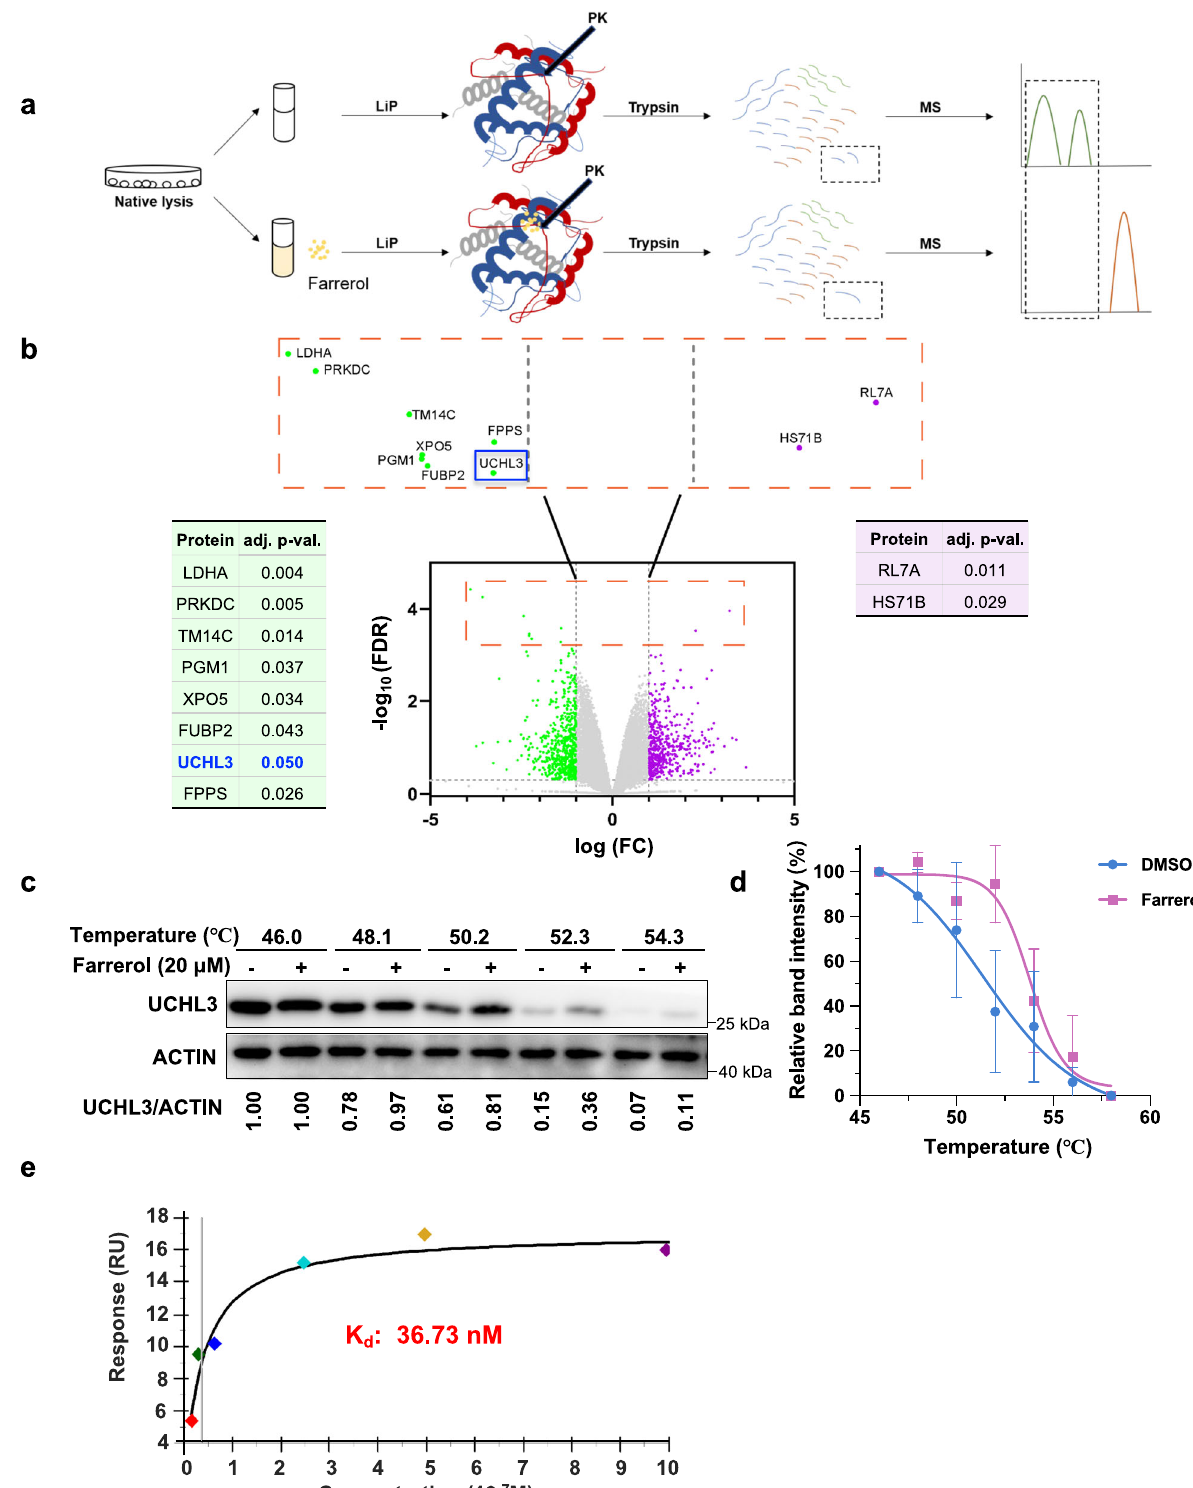
Supplementary Fig. 1e. The alignment indicated that farrerol did not affect the dynamic structure of